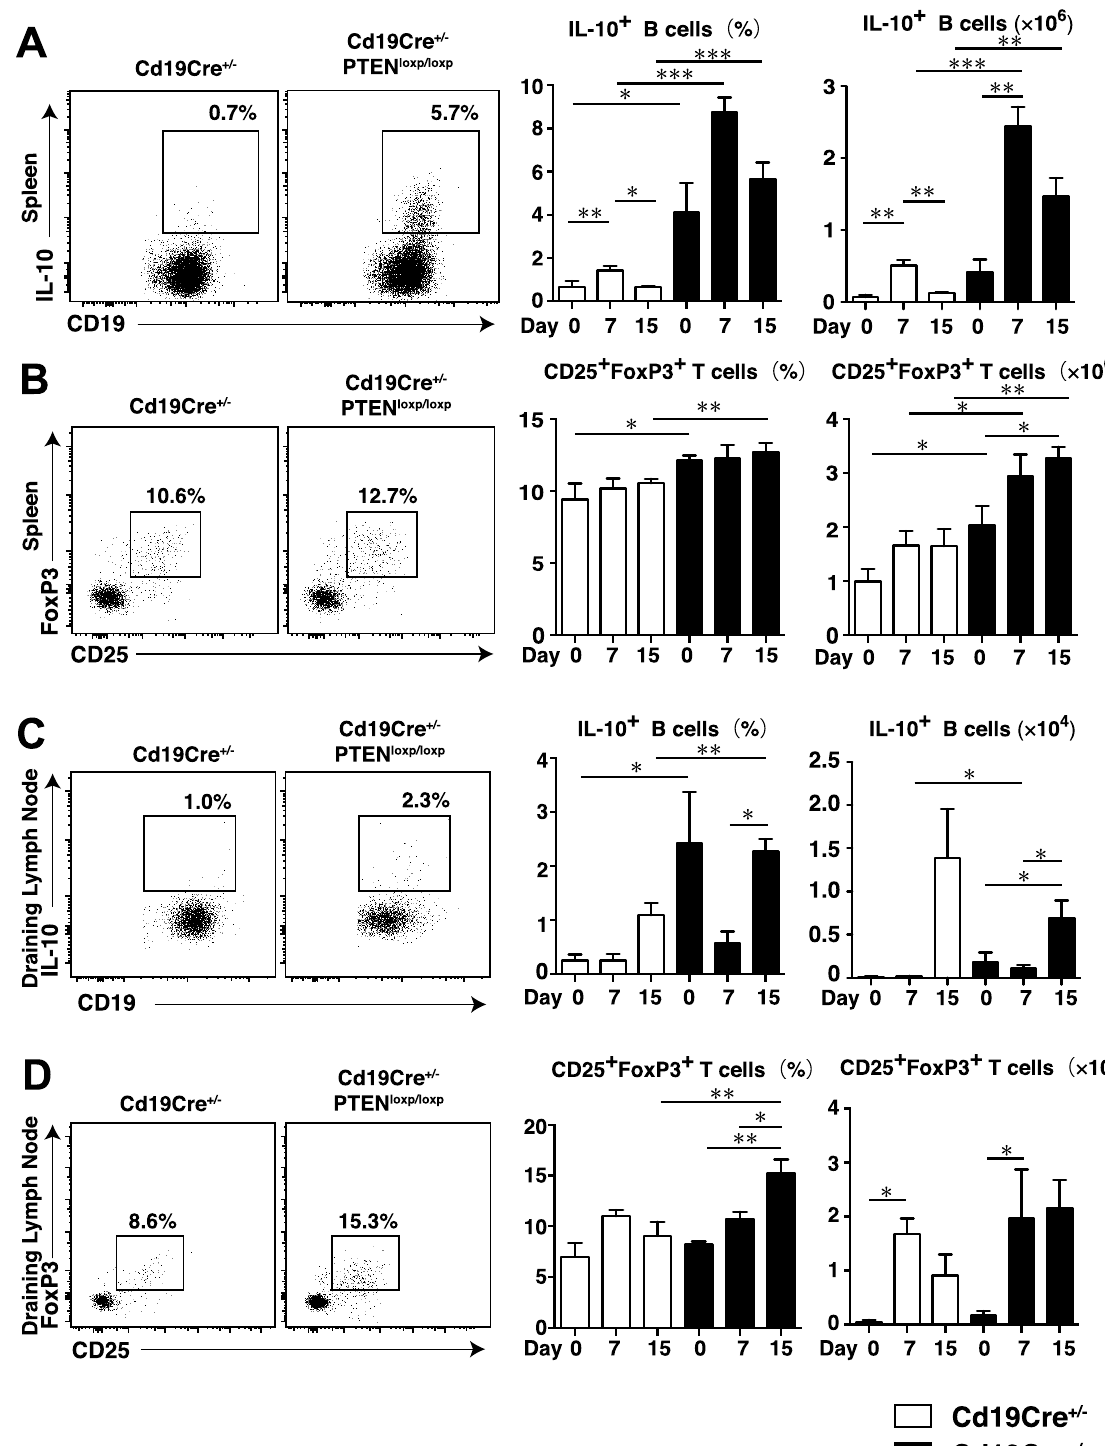
Figure 4. Tregs in the spleen and draining lymph nodes were expanded in rmIL-23-injected B cell-specific PTEN-deficient mice along with increased Bregs. The frequencies and numbers of IL-10-producing B cells ( A ) and CD25 + FoxP3 + T cells ( B ) in the spleen of rmIL-23-injected Cd19Cre + /− and Cd19Cre + /− Pten loxP/loxP mice. The frequencies and numbers of IL-10-producing B cells ( C ) and CD25 + FoxP3 + T cells ( D ) in the draining lymph node of rmIL-23-injected Cd19Cre + /− and Cd19Cre + /− Pten loxP/loxP mice. The images were created with FlowJo software (version 10.1R5; Tree Star, San Carlos, CA, USA, https ://www.flowj o.com/). Significant differences between samples means are indicated as: * P < 0.05, ** P < 0.01, *** P <